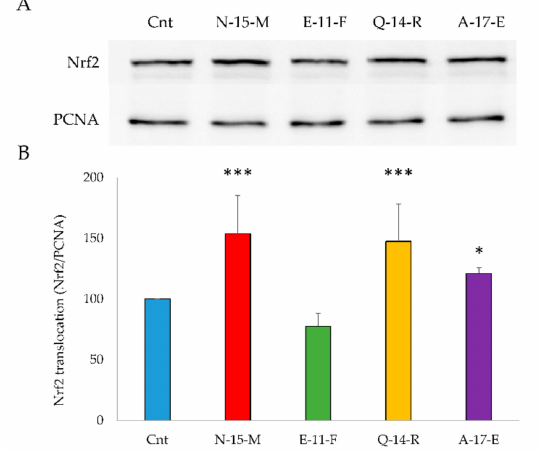
Figure 3. Nrf2 translocation from cytosol to nucleus in Caco-2 cells in the presence of N-15-M , E-11-F , Q-14-R and A-17-E . ( A ) Cells were treated with 0.05 mg / mL of each peptide for 24 h. Nuclear fractions were isolated and proteins were subjected to WB detection as indicated in paragraph 2.15. ( B ) Densitometric analysis of four experiments compared with the control were reported, using PCNA as loading control. (*** p < 0.001, * p <